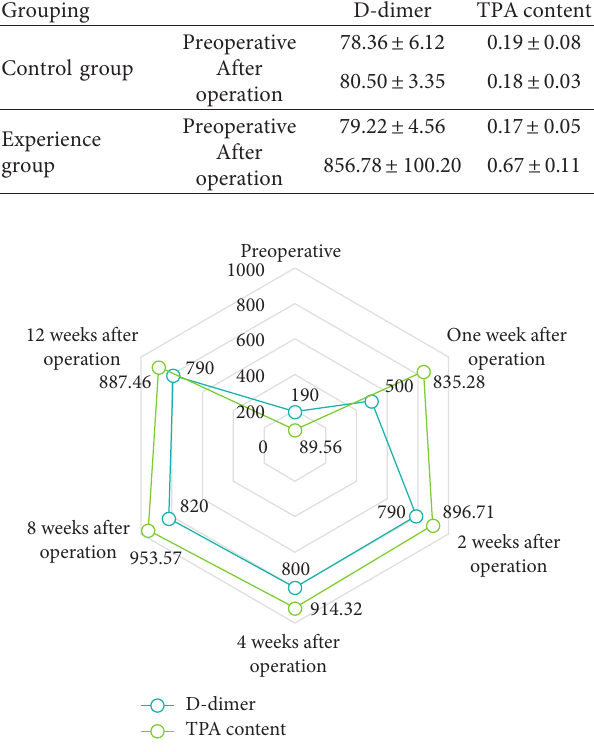
Figure 4: Changes of tPA and D-dimer in venous blood after valve replacement in control group ( x ± s , μ g/ml).